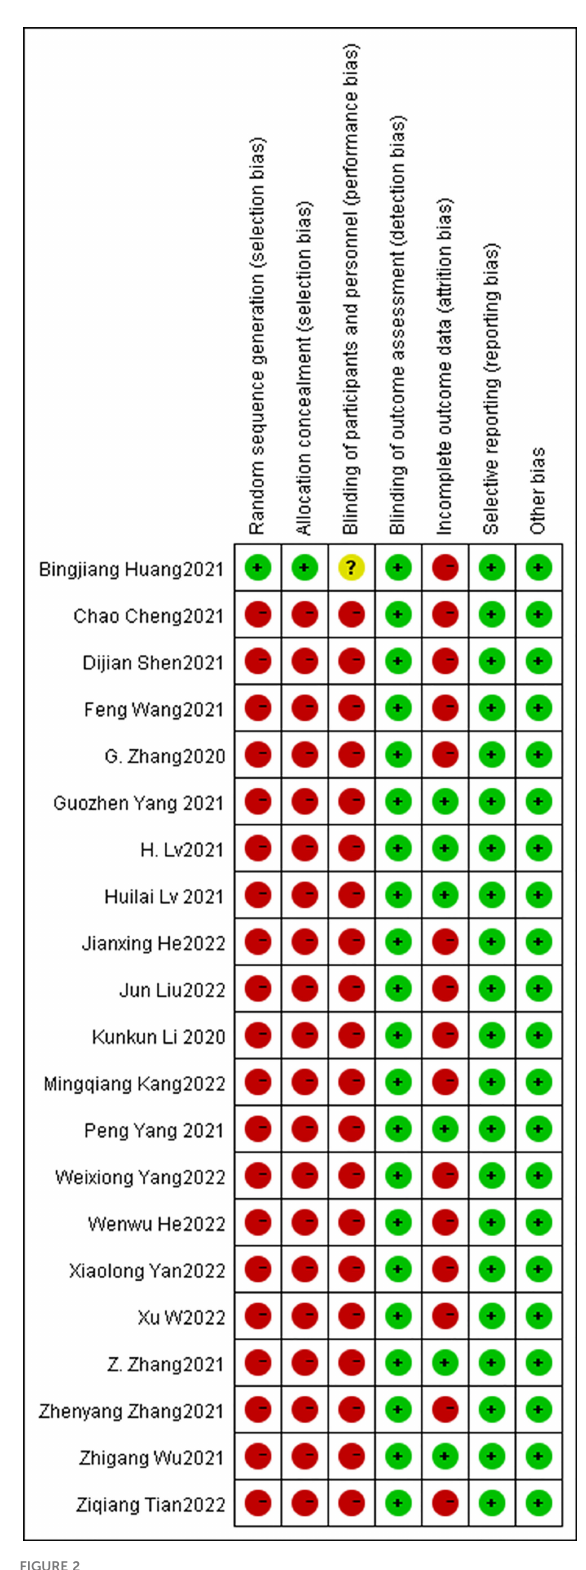
FIGURE 2 Assessments of Publication Bias and Study